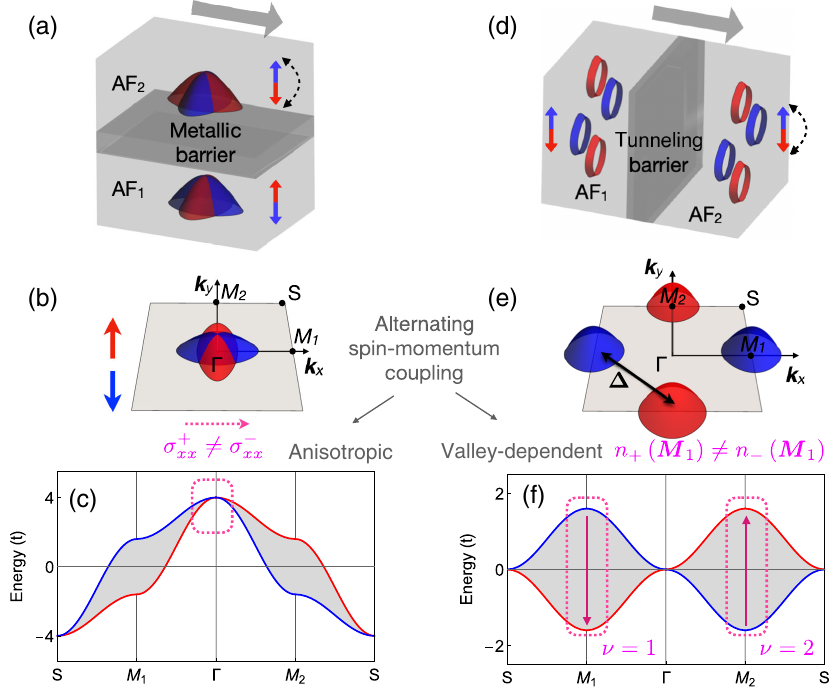
FIG. 1. Archetype GMR and TMR model mechanisms in unconventional antiferromagnets. Red and blue correspond to up and down spins, respectively, and a gray arrow marks the applied current direction. (a) The GMR stack with a metallic spacer in a current-in-plane geometry. As an example, we show the antiparallel configuration of the N´eel vectors in the two electrodes AF 1 and AF 2 . Interfaces are oriented along one of the main axes of the elliptic spin-dependent bands. (b) Energy band cuts highlighting the anisotropic alternating spin-momentum coupling around the Γ point in the Brillouin zone, resulting in anisotropic spin-dependent conductivities. (c) The tight- binding model band dispersion. The dashed rectangle highlights the region with the anisotropic spin-momentum coupling around the Γ point. (d) The TMR stack with an insulating barrier. As an example, we show the parallel configuration of the N´eel vectors in the two electrodes. (e) Energy band cuts highlighting the valley-dependent alternating spin-momentum coupling around the M 1 and M 2 points in the Brillouin zone, resulting in valley and spin-dependent densities of states. (f) The tight-binding model band dispersion. The dashed rectangles highlight the valleys with opposite spin splitting, marked by the magenta